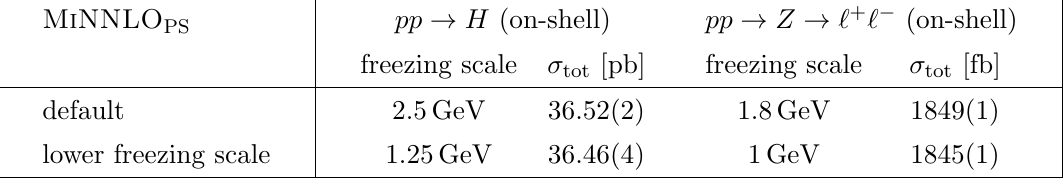
Table 1 . Total inclusive cross sections for Higgs-boson production and DY production using the MiNNLO PS calculations, for di(cid:11)erent values of the freezing